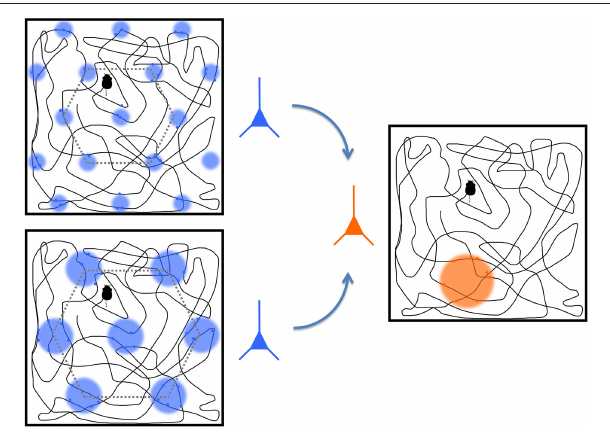
FIGURE 5 | A representation of two grid cells (blue) and a place cell (orange). The boxes show trajectories of a rat throughout a space with colored circles representing the regions where the cell fires the most. The grid cells, located in entorhinal cortex, operate at different spatial scales, and they project to the place cell in the hippocampus. The place cell convolves the responses from the grid cells to derive its preferred place at which it responds most strongly. Modified from Solstad et al. (2006) and from Nobelprize.org.